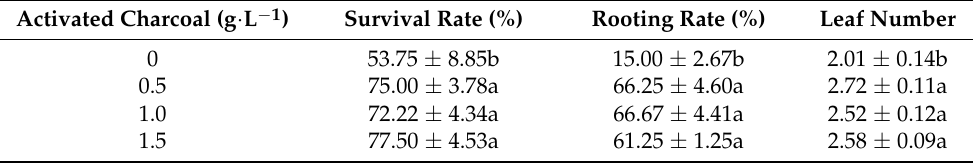
Table 6. Effect of activated charcoal on root and leaf growth of Paphiopedilum tigrinum .